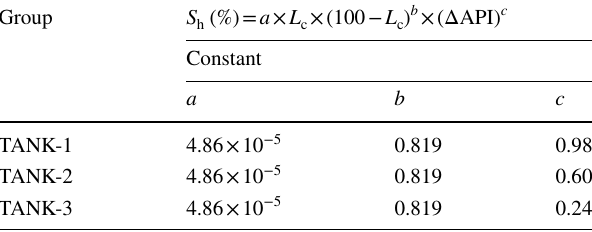
The constants of a, b, c are referenced from PSME of UPN